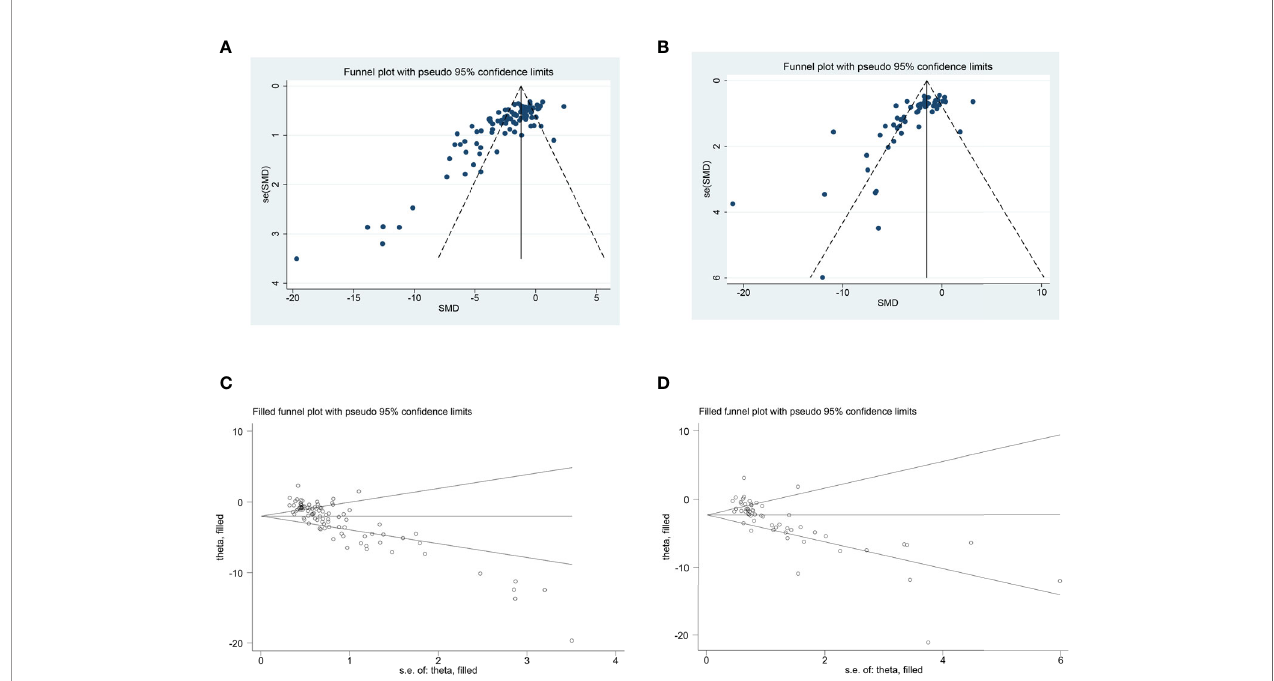
FIGURE 4 | The evaluation of publication bias. Funnel plots for clinical score (A) and remyelination (B) . Each dot in the fi gure represents a study, with the y-axis signifying study quality and the x-axis showing the study results. (C, D) Trim-and- fi ll method was used to evaluate the missing studies in clinical score and remyelination. SMD, standardized mean